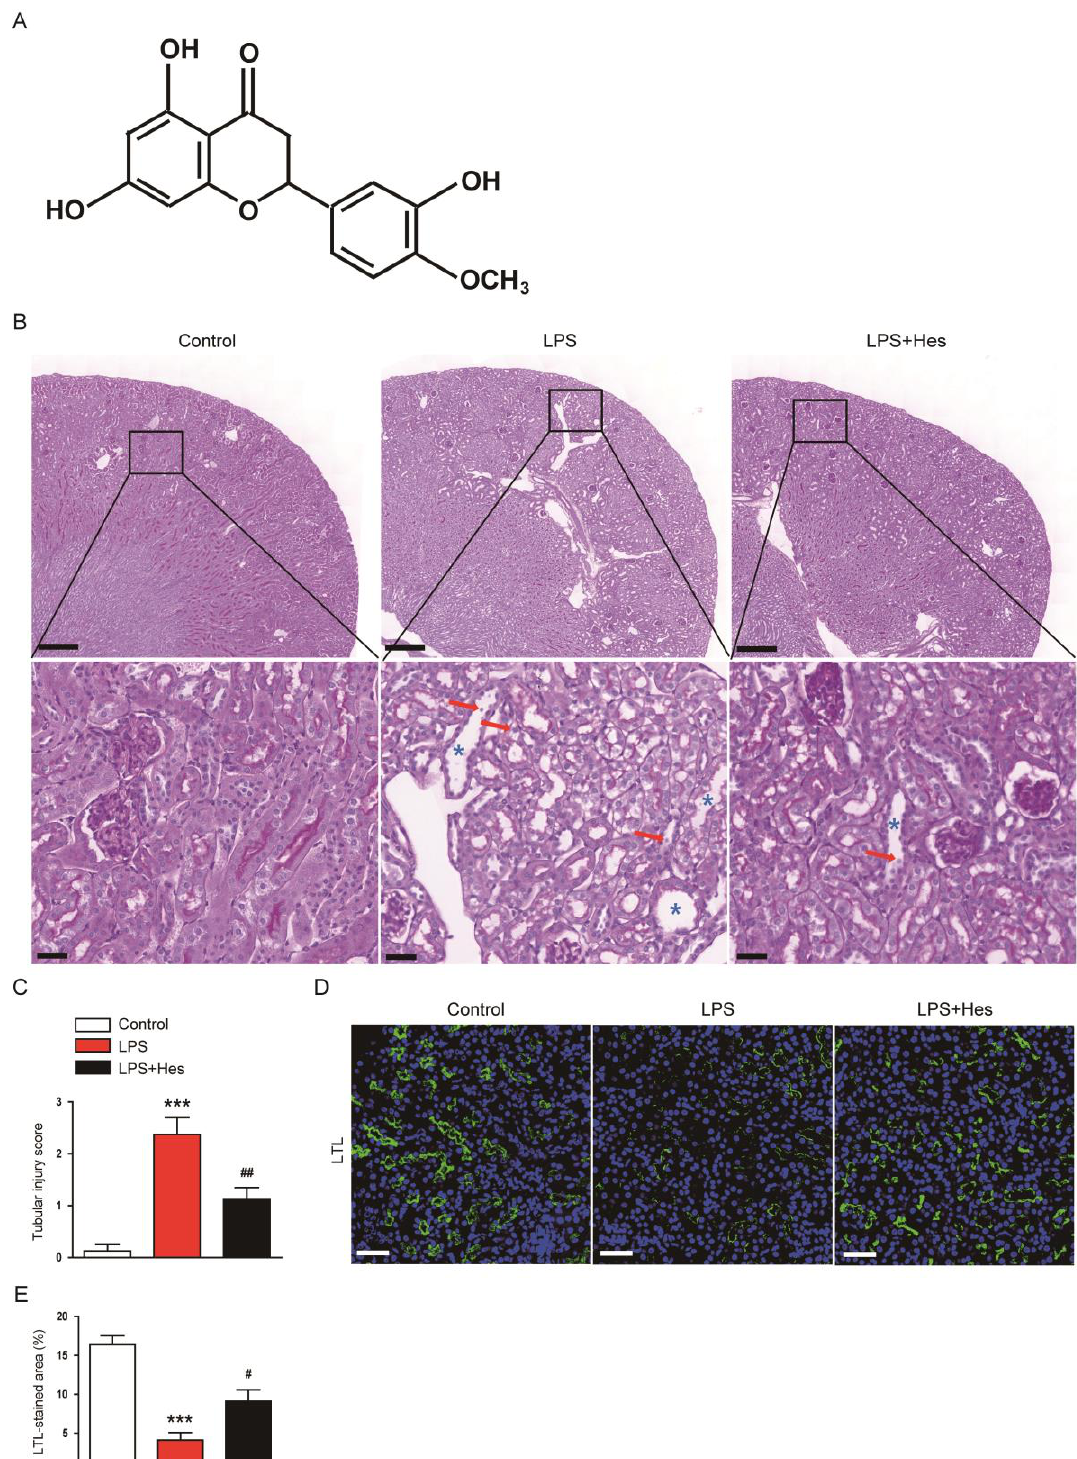
Figure 1. Hesperetin ameliorated histological abnormalities in lipopolysaccharide (LPS) - injected mice. ( A ) The chemical structure of hesperetin. ( B ) Periodic acid - Schiff (PAS) staining. Red arrows indicate detached tubular cells. Blue asterisks indicate dilated tubules. Scale bars: 300 μm (upper panel) and 30 μm (lower panel). ( C ) Tubular injury score. ( D ) Lotus tetragonolobus lectin (LTL) staining (green). Nuclei were stained with 4′,6 - diamidino - 2 - phenylindole (DAPI; blue). Scale bar: 50 μm. ( E ) Percentage of the LTL - stained area per field. n = 8 per group. *** p < 0.001 vs. Control. # p < 0.05 and ## p < 0.01 vs. LPS.